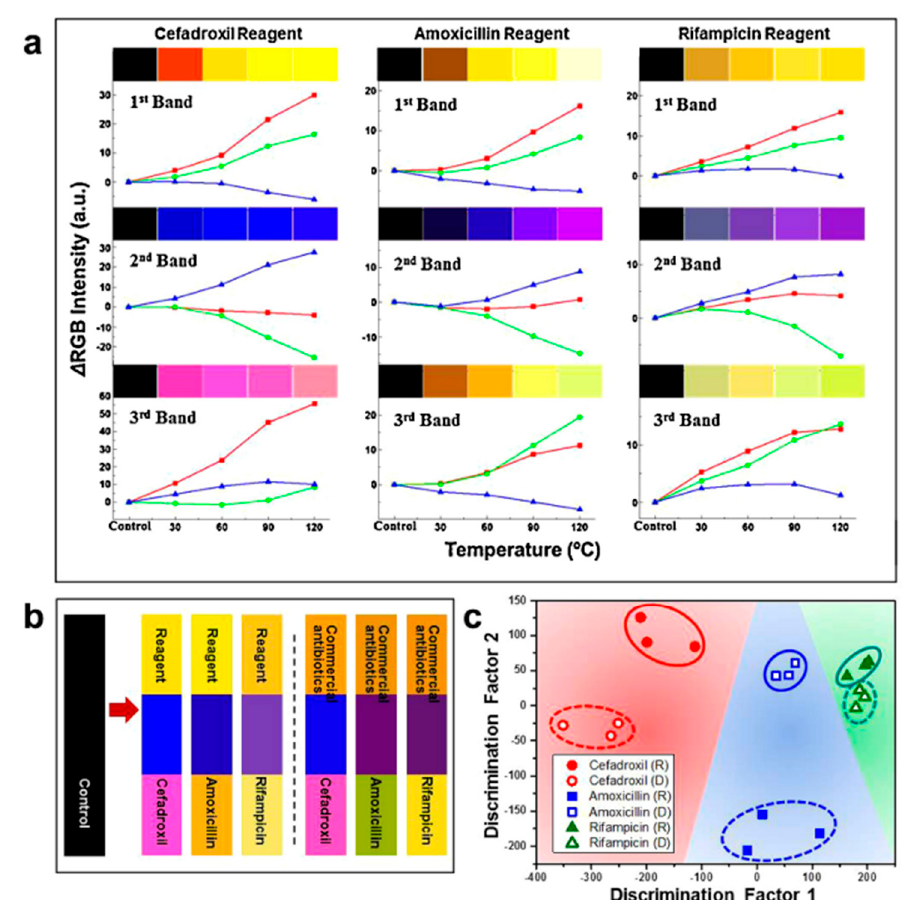
Figure 10. Each analyte (here three antibiotics) causes a unique color pattern that is highly temperature-dependent ( a ). Phage-based colorimetric sensors enable recognition of pure antibiotics from each other and a pure antibiotic from a commercially available form (with additional substances that interact with M13 structure) ( b ). Two-dimensional color pattern presentation shows a characteristic distribution of measured signals. Pure antibiotics (fulfilled signs) and their commercial forms (hollow signs) may be easily recognized with good accuracy ( c ) [94]. Reprinted from [94], Copyright 2017, with permission from Elsevier.